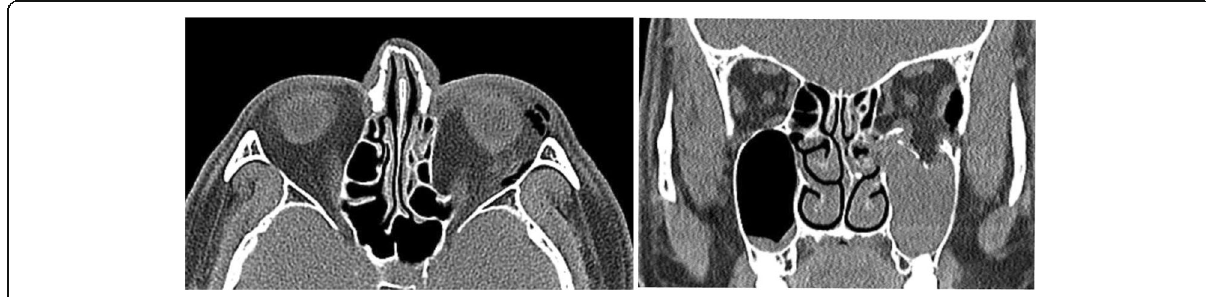
Fig. 7 Preoperative CT (axial and coronal sections)